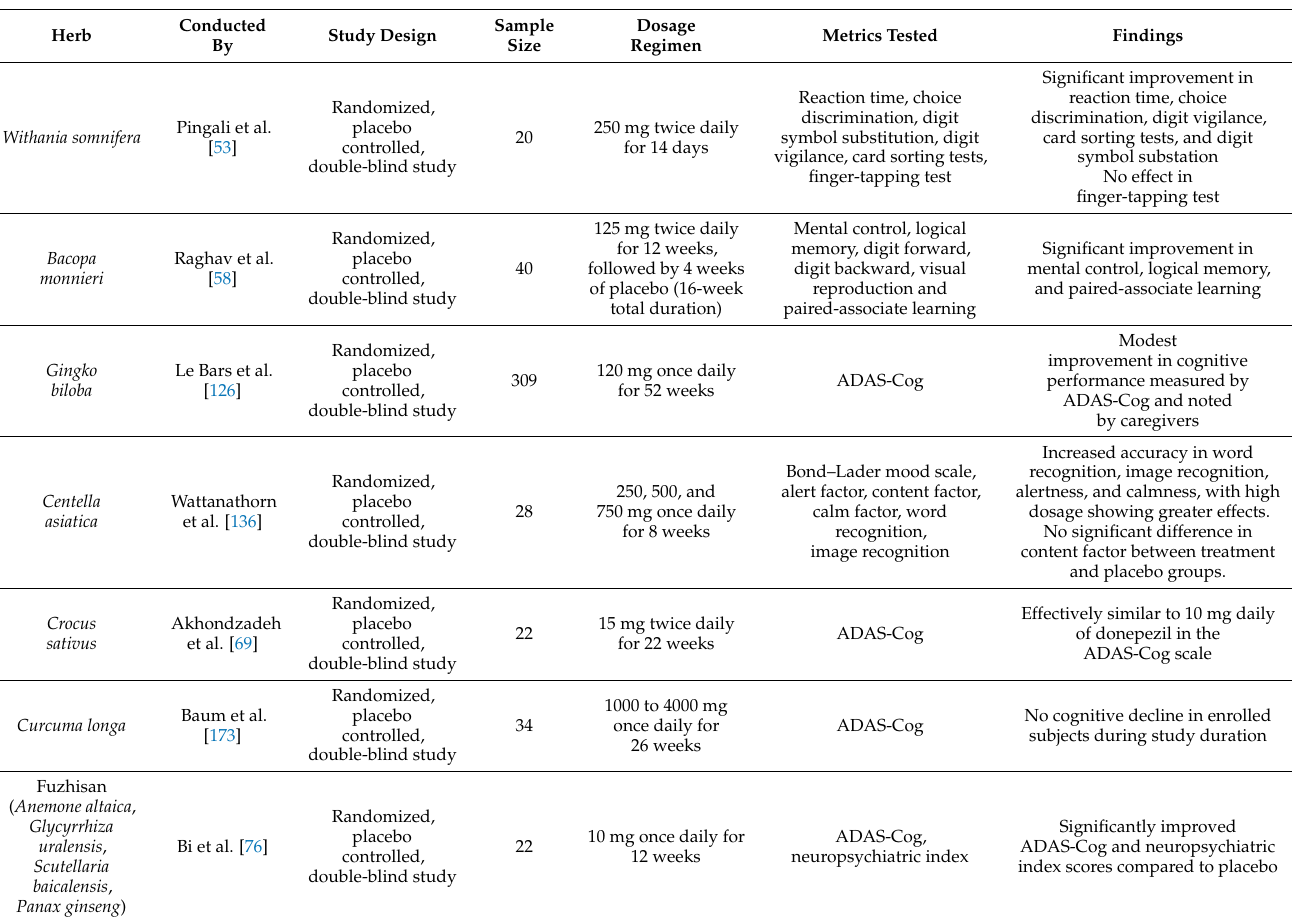
Table 2. Neurotherapeutic effects of Withania somnifera, Bacopa monnieri, Gingko biloba, Centella asiatica, Crocus sativus, Curcuma longa, and Fuzhisan in randomized, placebo controlled human trials. In these trials, no severe adverse effects were noted for any of the administered extracts or natural